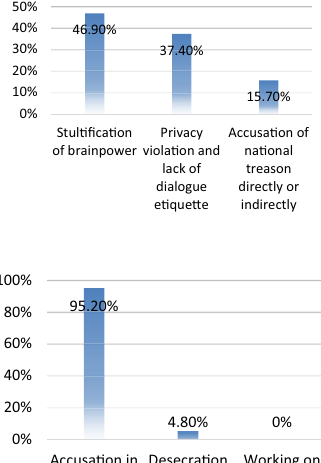
Figure 7. Religious insult